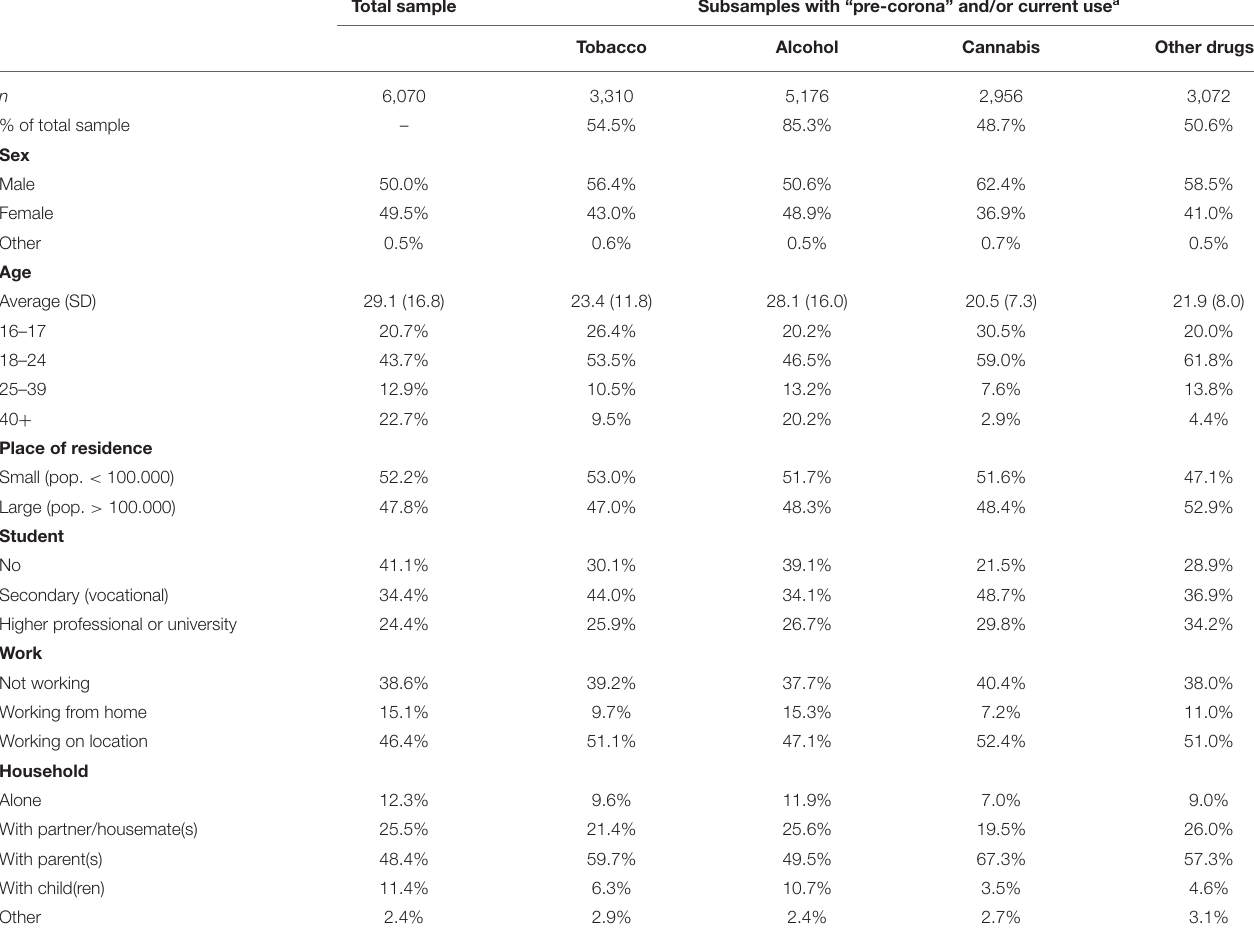
TABLE 1 | (Sub)sample